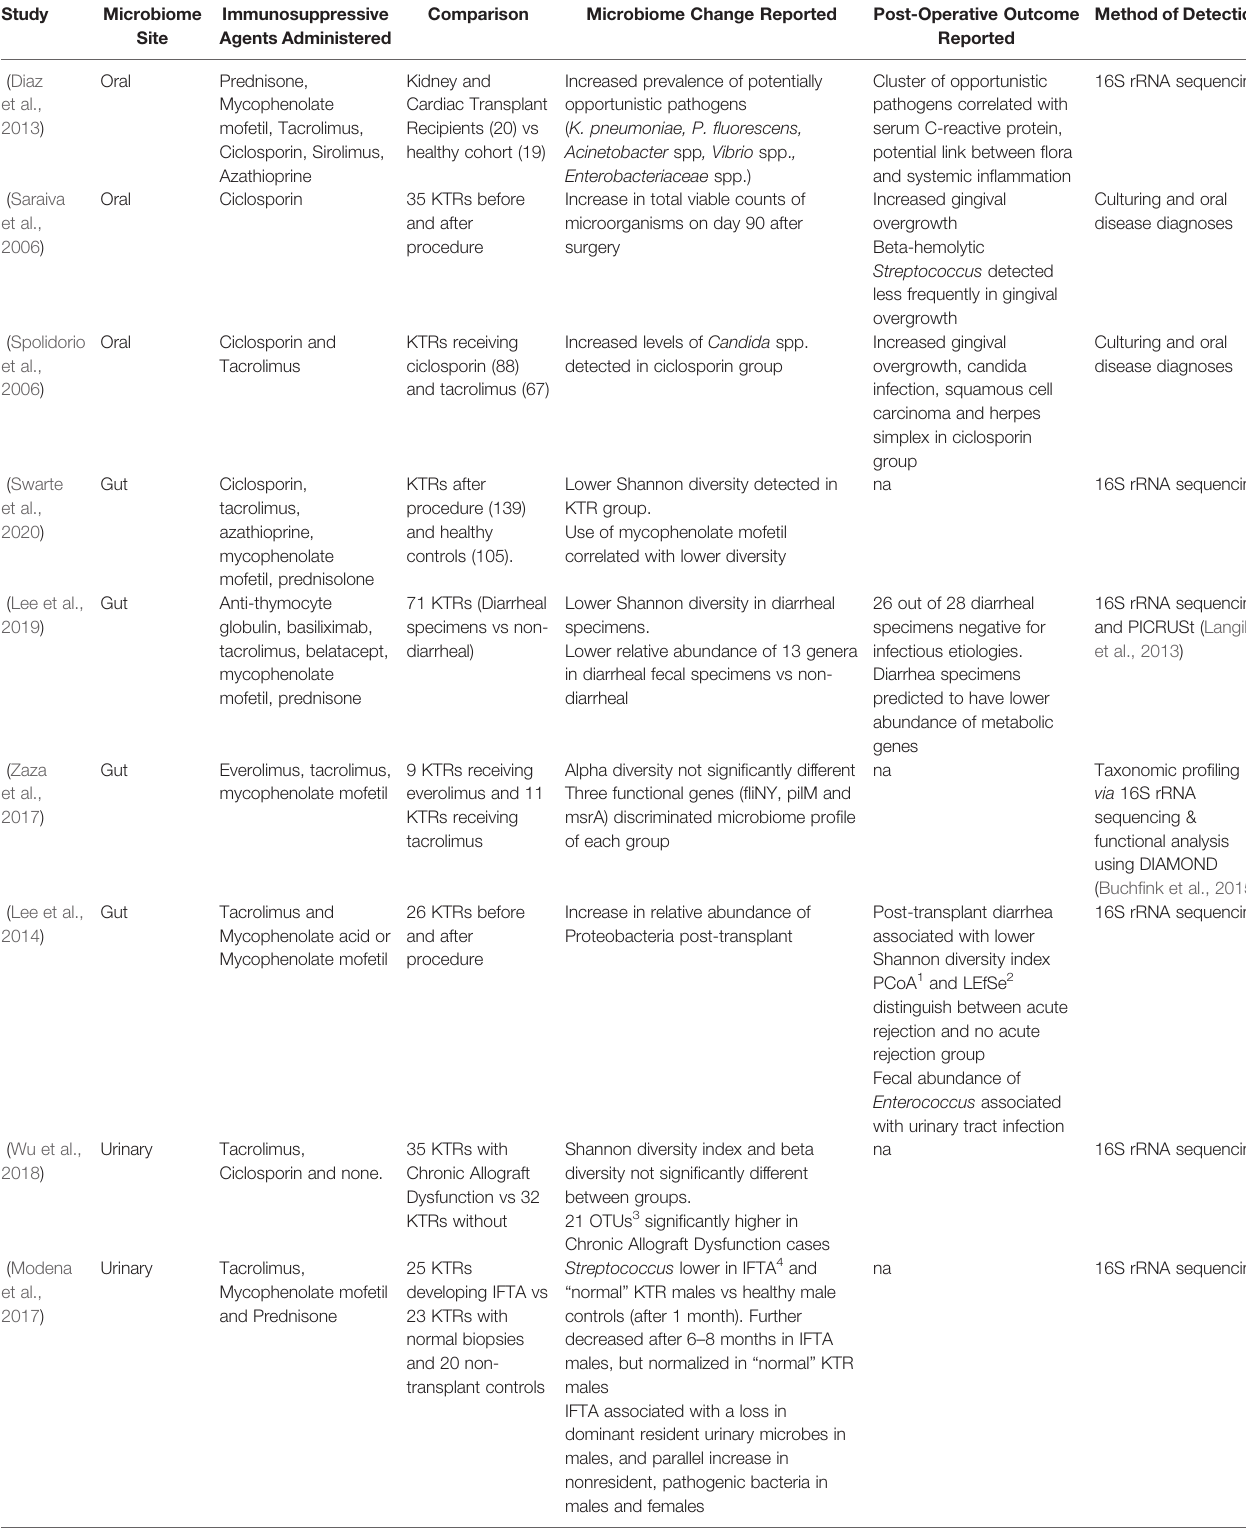
TABLE 1 | Summary of recent studies reporting microbiome-associated differences (and their, potentially, related, post-operative effects) using kidney transplant recipient (KTR)